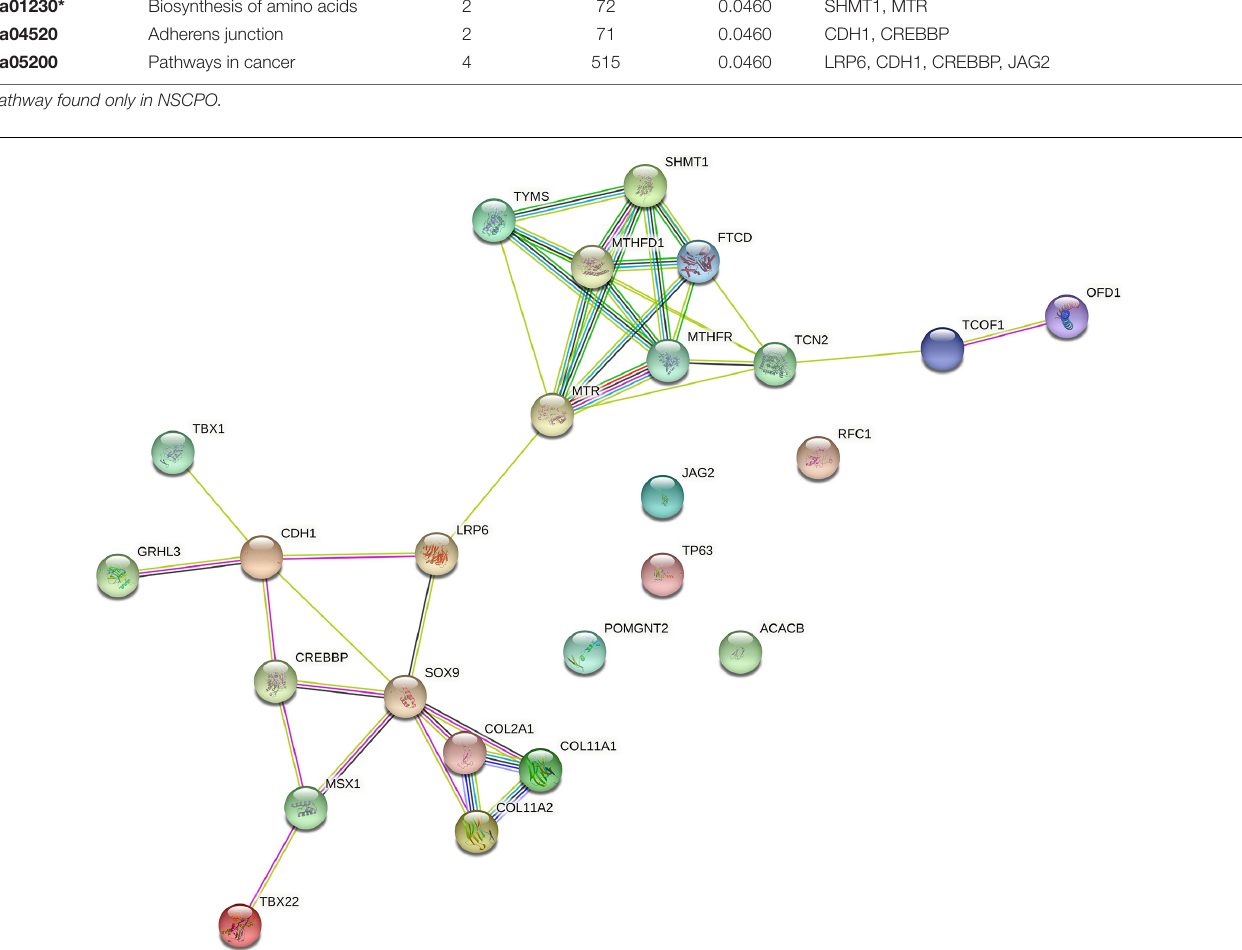
FIGURE 2 | Protein–protein interaction network with the genes associated with non-syndromic cleft palate only (NSCPO). Twenty out of 25 genes formed two nodes interconnected by a validated interaction between LRP6 and MTR . The first encompassed nine genes, including FTCD , MTHFD1 , MTHFR , MTR , OFD1 , SHMT1 , TCN2 , TCOF1 , and TYMS ( P < 1.0e-16), and the second node involved CDH1 , COL2A1 , COL11A1 , COL11A2 , CREBBP , GRHL3 , LRP6 , MSX1 , SOX9 , TBX1 , and TBX22 ( P < 1.0e-16). Both nodes were based on curated databases (light blue), experimentally (purple), gene neighborhood (green), gene fusions (red), gene co-occurrence (blue), text mining (light green), co-expression (black), and protein homology (violet). This analysis had an average confidence score of 0.588 ( P < 1.0e-16), suggesting a low rate for false-positive